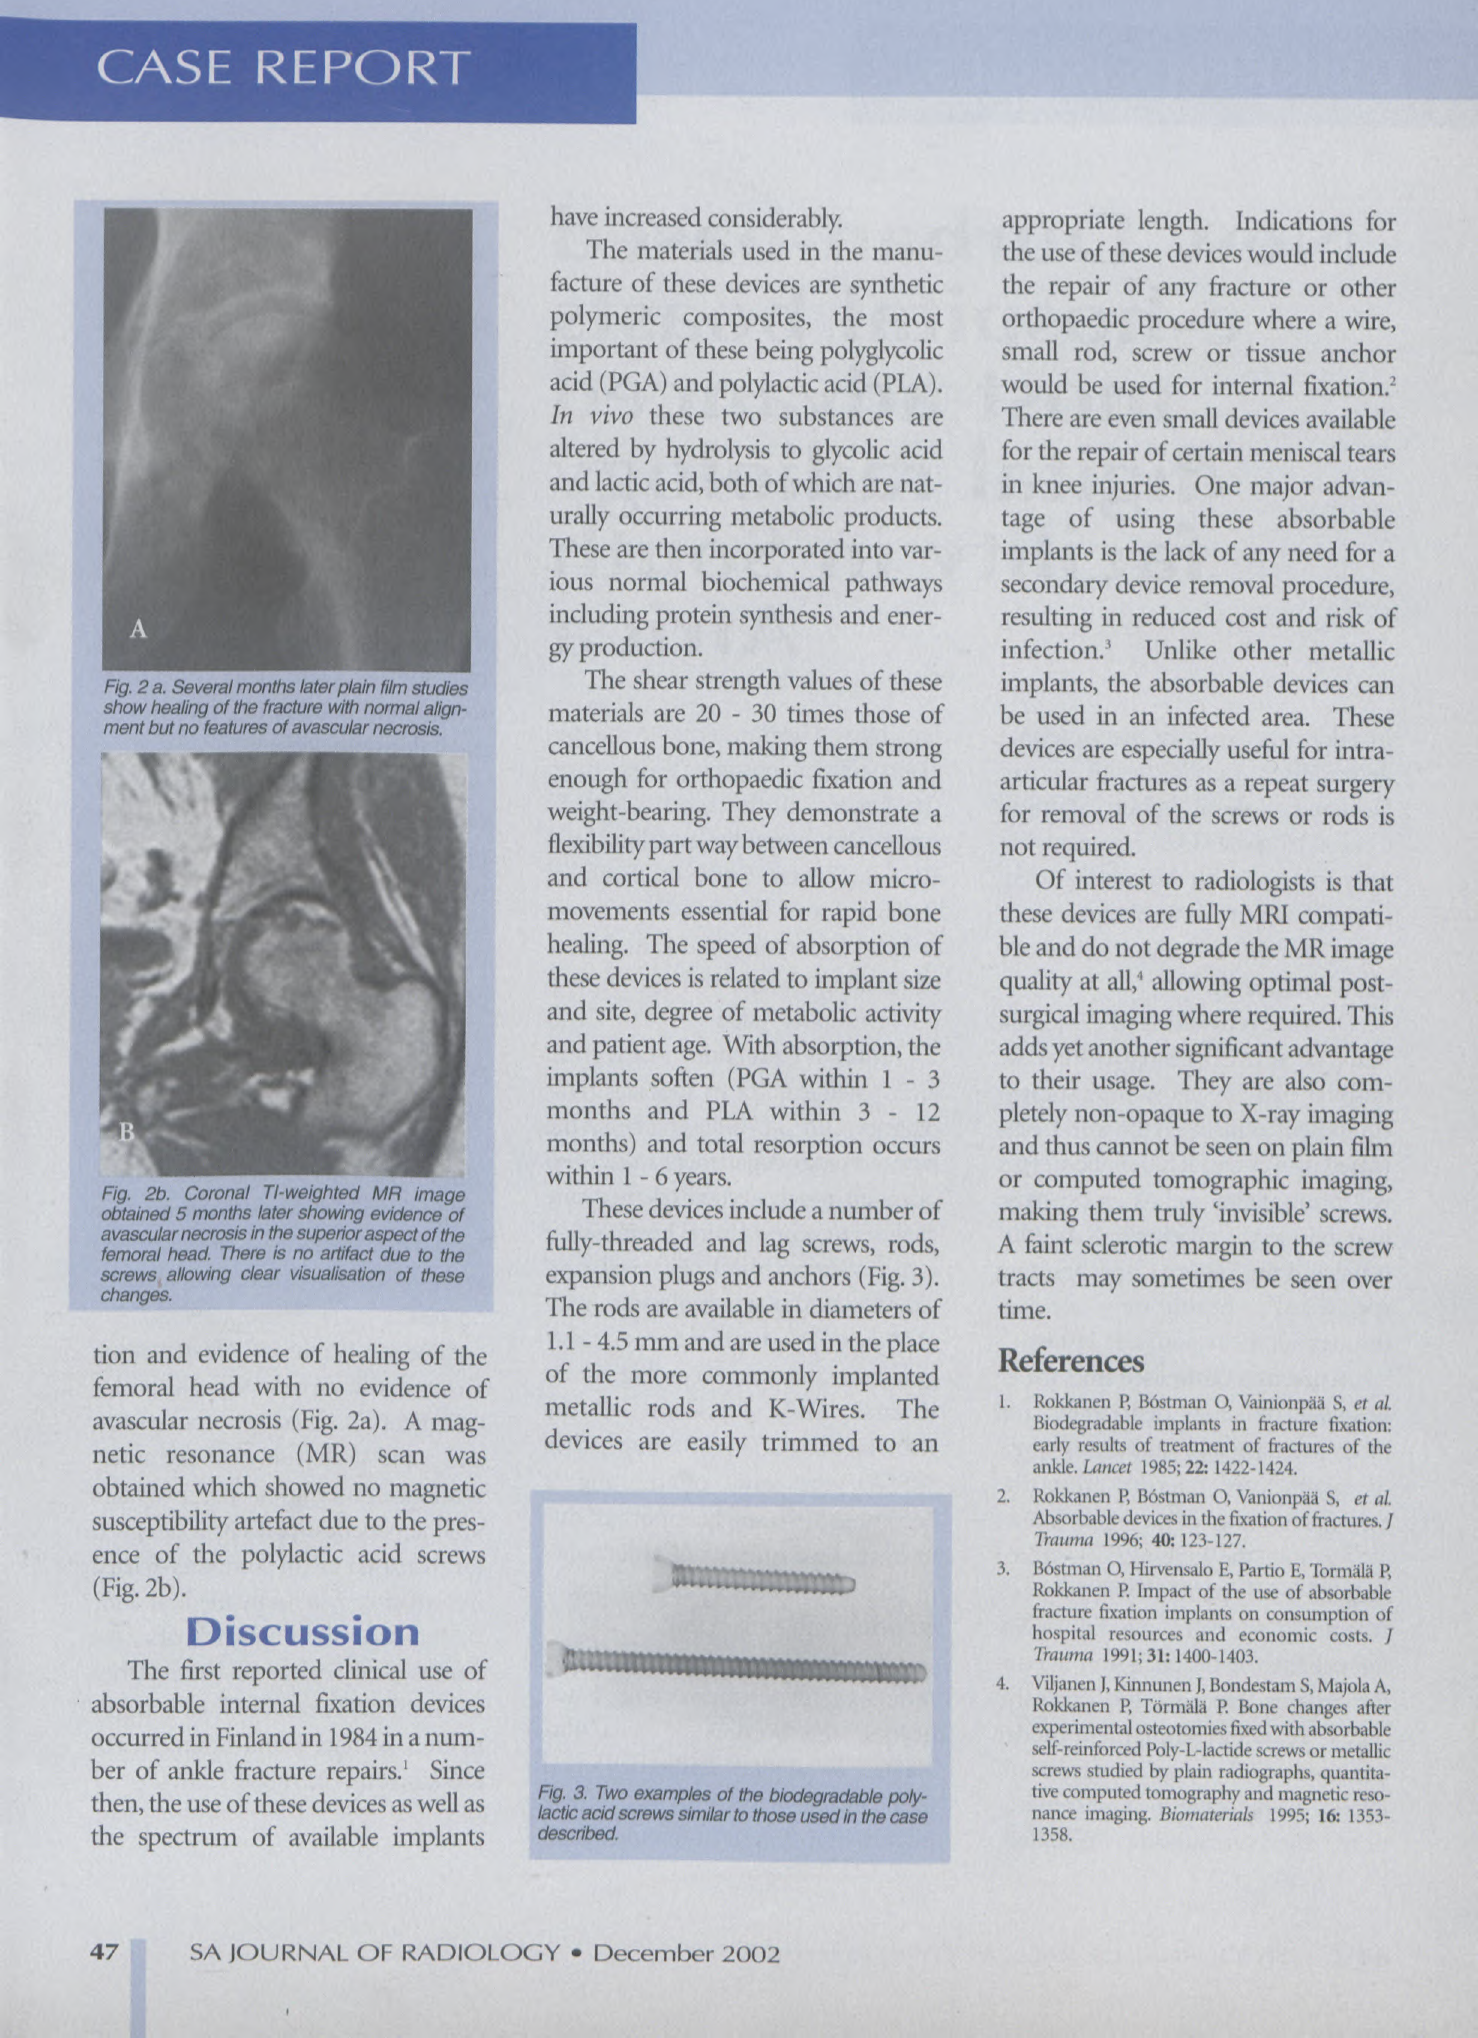
Fig. 3. Two examples of the biodegradable poly- lactic acid screws simi/arto those used in the case